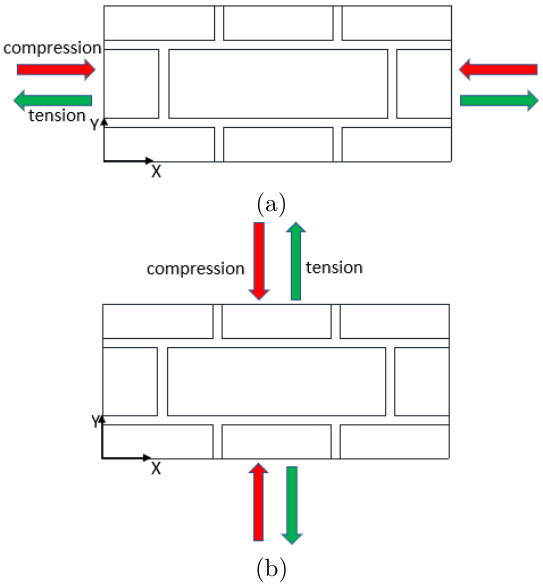
Figure 6. Applied loading: a) E T = {± E E T = { 0 , ± E yy , 0 }